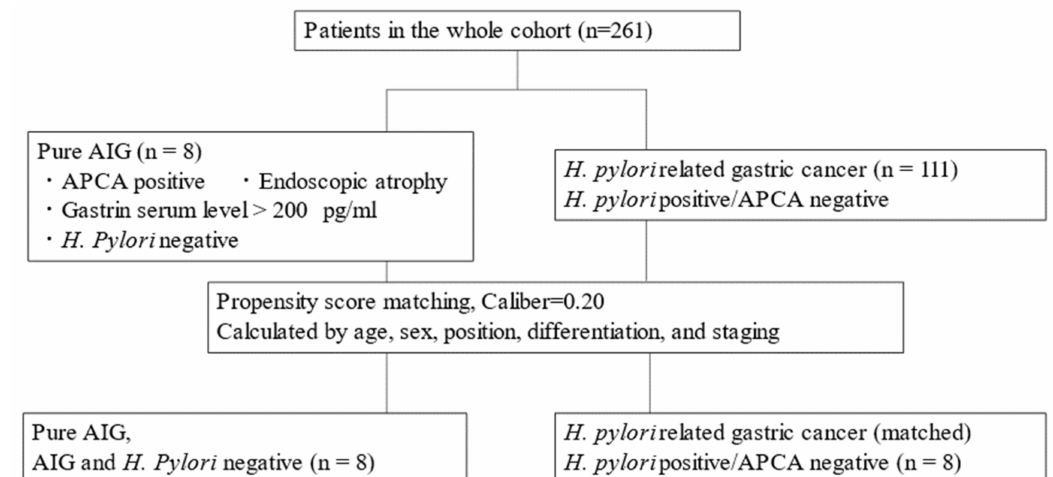
Figure 1. Patient selection